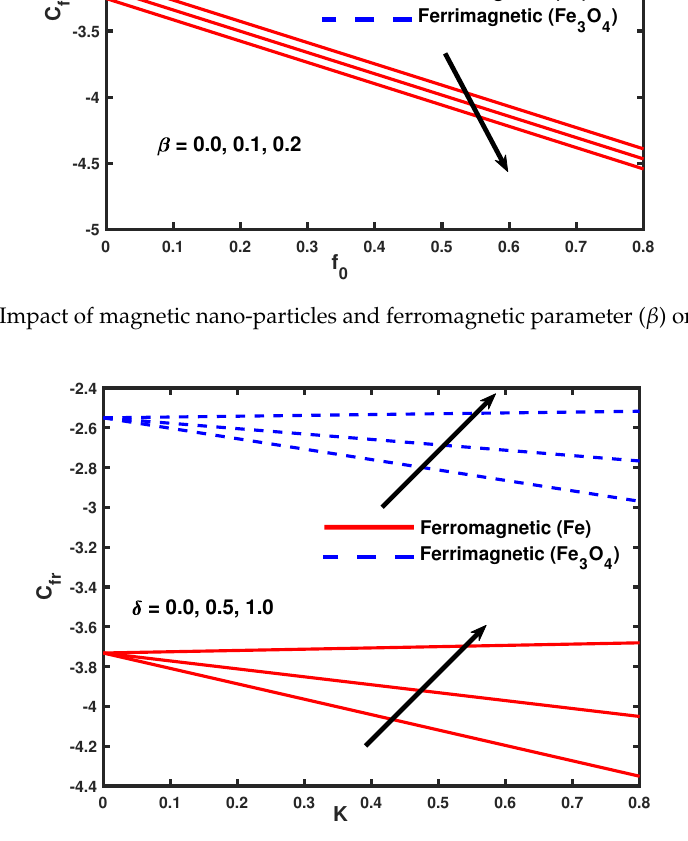
Figure 19. Impact of magnetic nano-particles and boundary parameter ( δ ) on skin